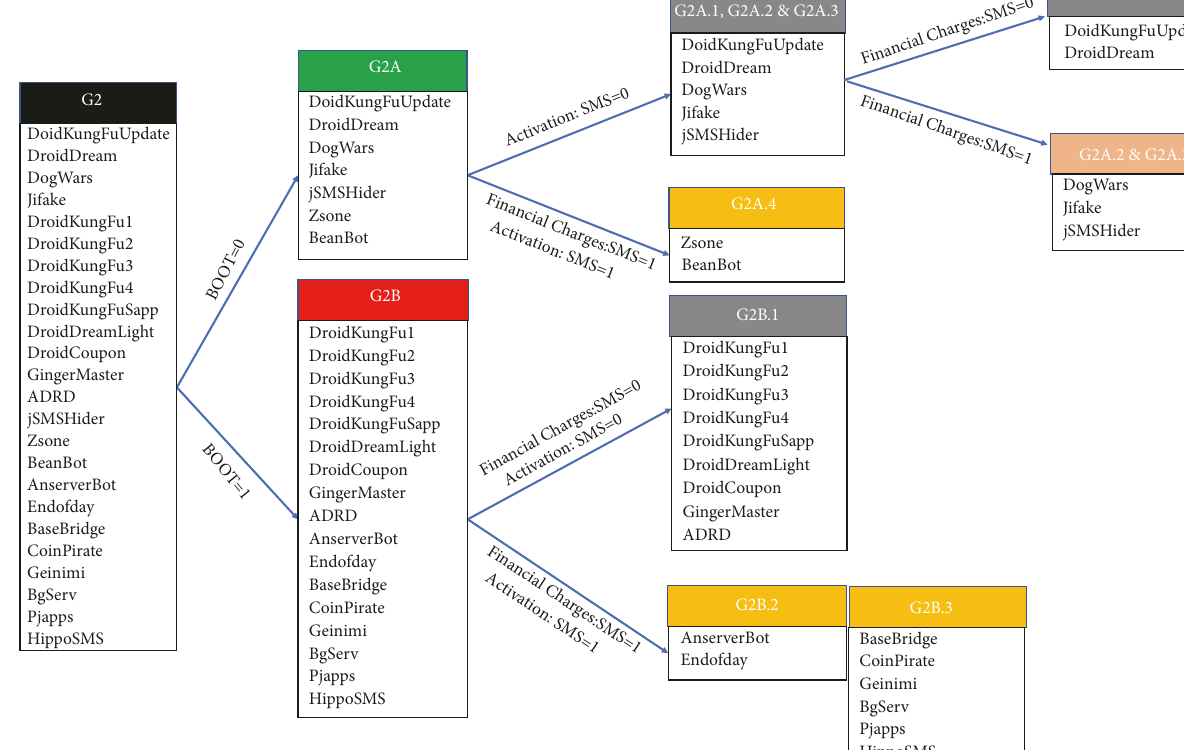
Figure 6: Families allocation in Group 2 and relevant features identified in BHL